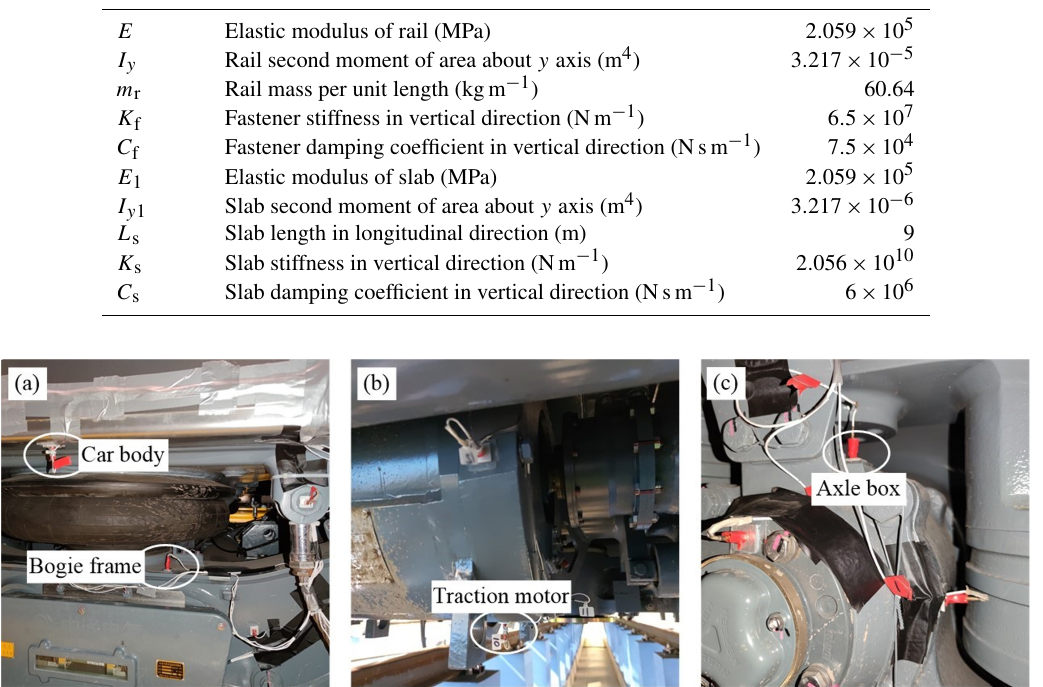
Figure 4. Accelerometer sensors on (a) the car body and bogie frame, (b) traction motor, and (c) axle box.